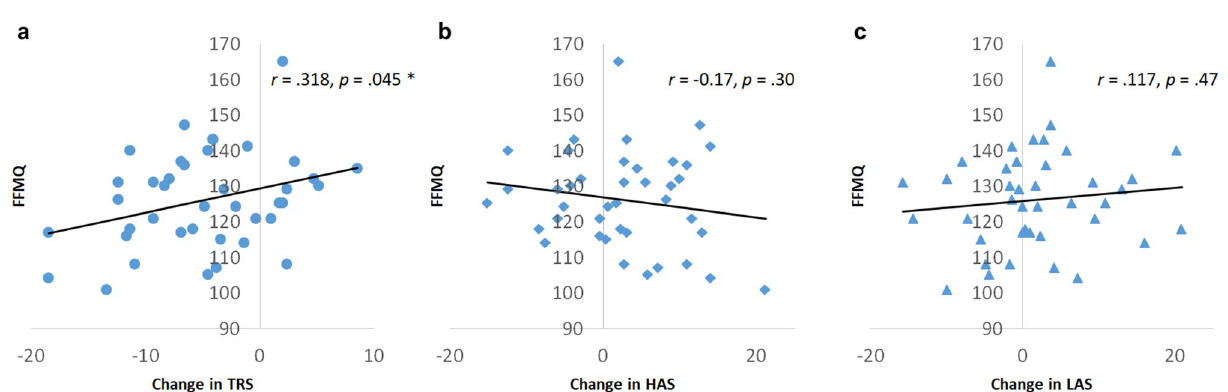
Figure 4. Trait mindfulness measured with the Five Facet Mindfulness Questionnaire (FFMQ) correlates positively with the change in proportion of time spent in the task ready state (TRS) due to stress ( a ), but is not associated with the arousal-related states ( b , c